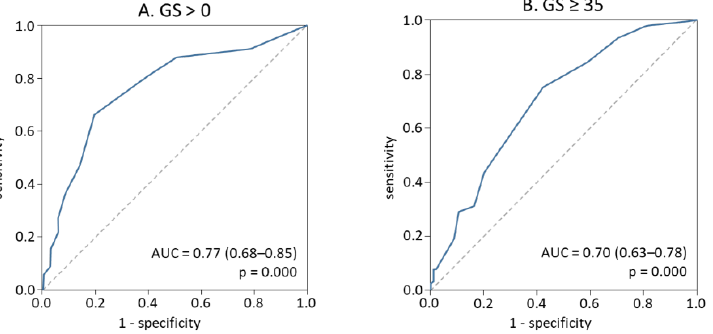
Figure 1. ROC-curve analysis for the prediction of coronary atherosclerosis presence ( A ) or severity ( B ) by i-BIO in the initial cohort.